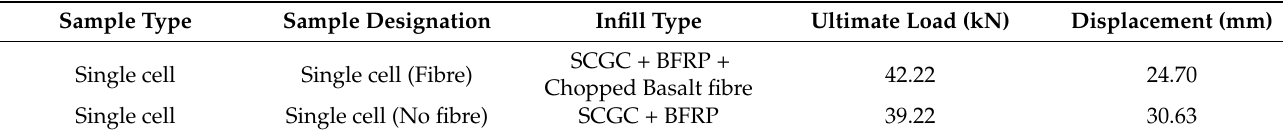
Table 3. Results of single-cell composite floor